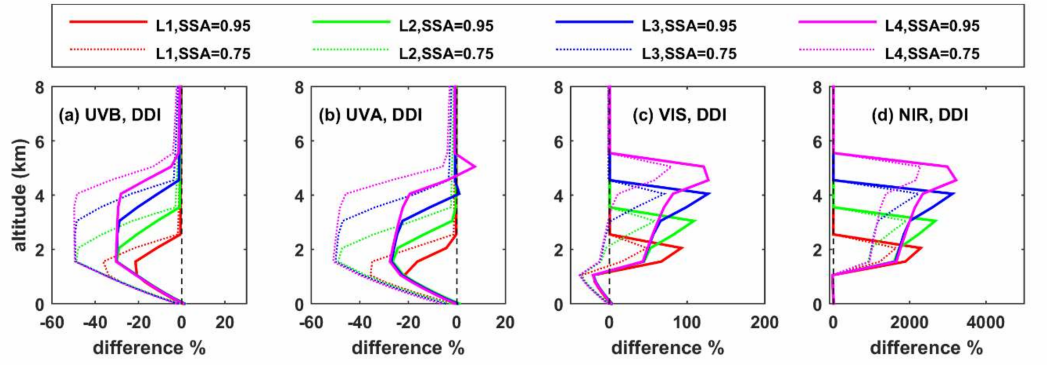
Figure A9. Same as Figure 4, but for SZA = 80 ◦ instead of 60 ◦ . Note that the x-axis scale is different relative to Figure 4.